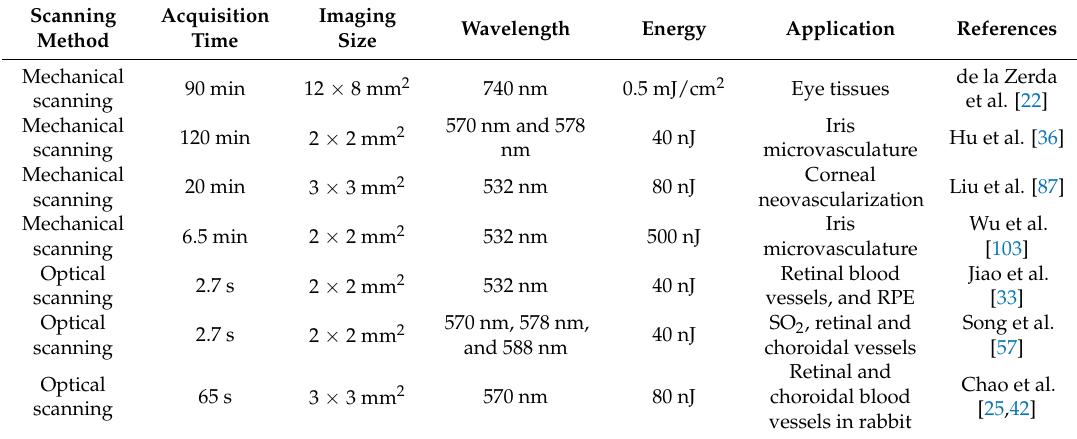
Table 5. Summary of acquisition time of photoacoustic ophthalmic